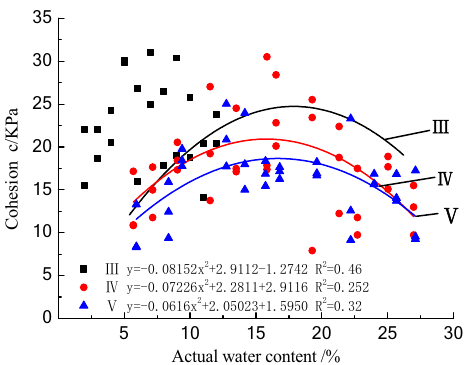
Figure 7. The relationship between the cohesion and moisture